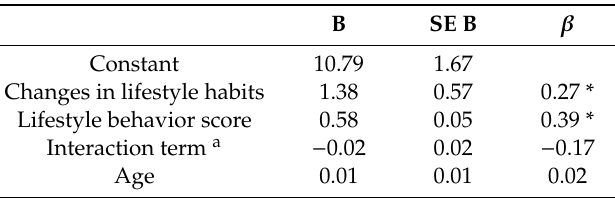
Table 3. Evaluating associations between reported changes in lifestyle habits and purpose in life in multiple linear